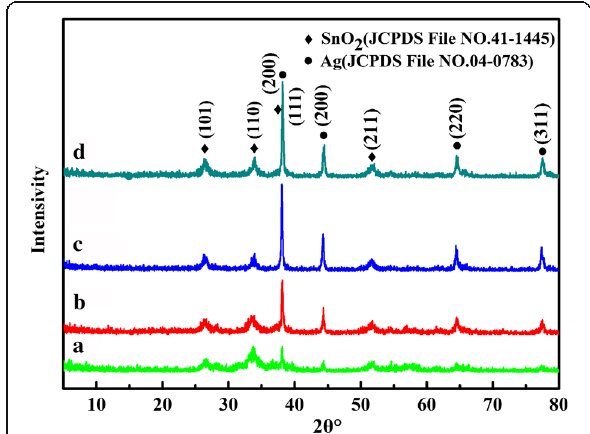
Fig. 1 XRD patterns of the Ag-decorated SnO 2 microspheres prepared at 150 °C for different times ( a ) 5 h, ( b ) 10 h, ( c ) 24 h, and ( d ) 36